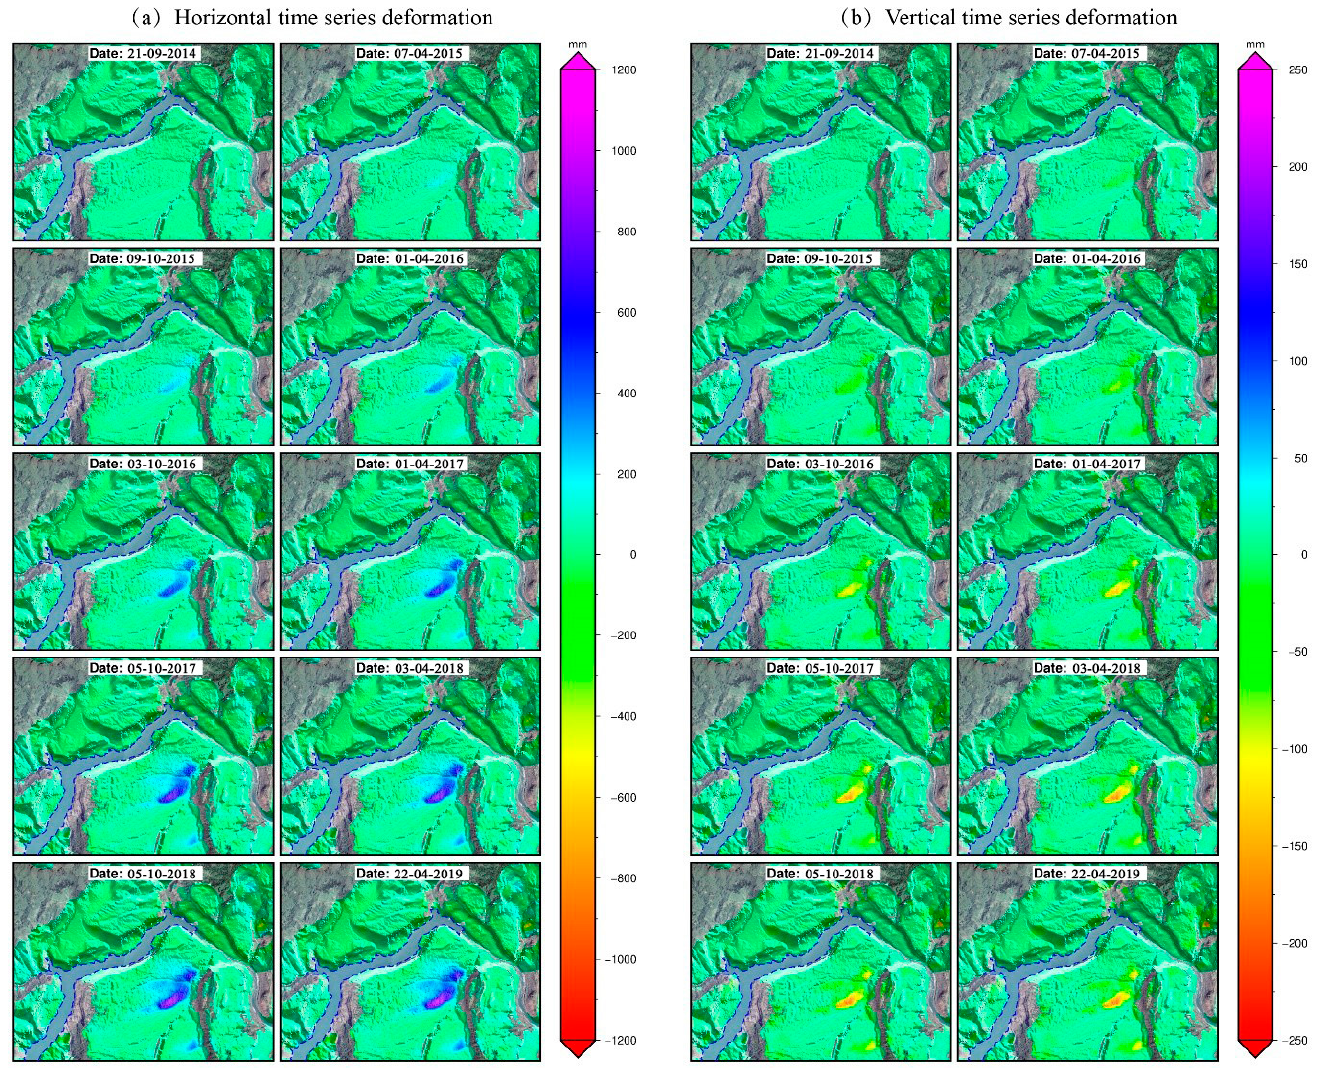
Figure 11. ( a ) Horizontal time-series deformation; ( b ) vertical time-series